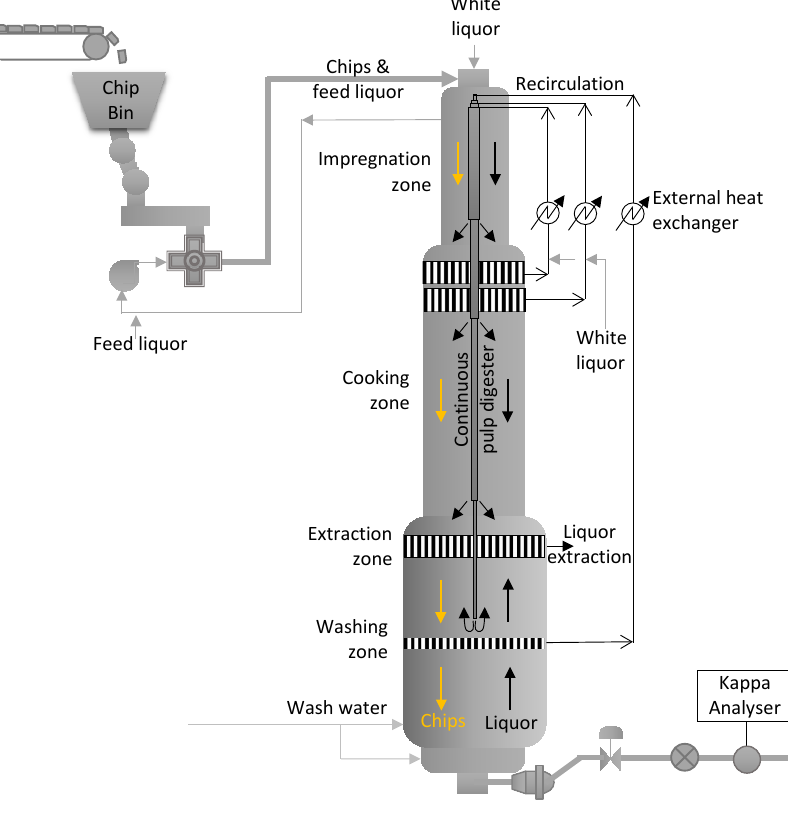
Figure 3. Schematic of a continuous pulp digester process flow